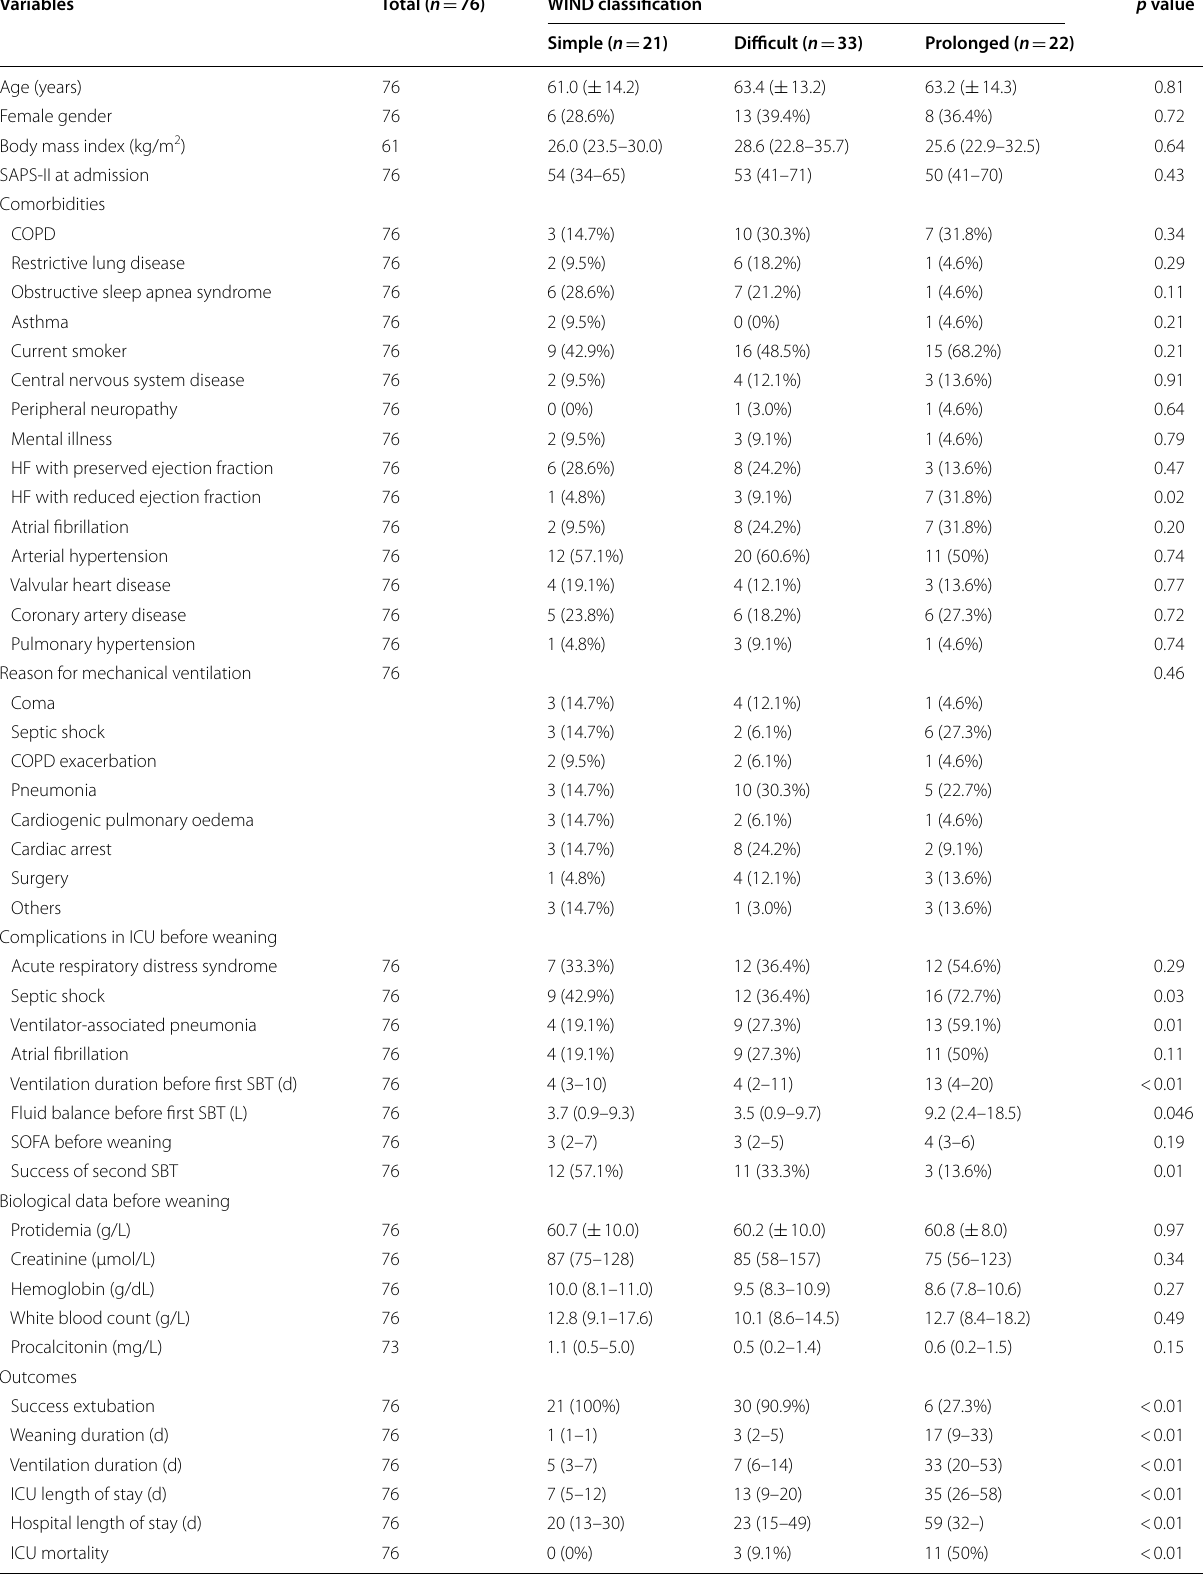
Table 1 Clinical and biological characteristics of patients according to WIND